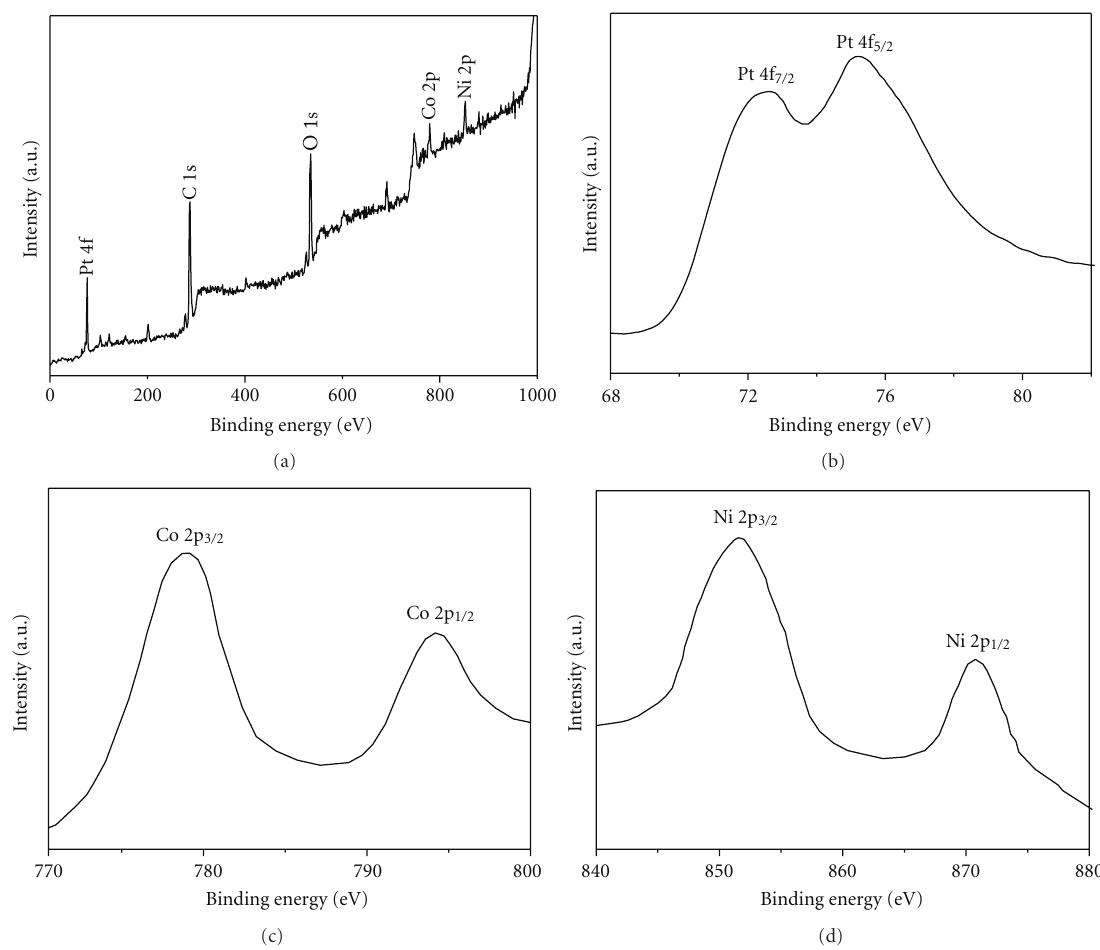
Figure 2: (a) XPS spectrum for Pt 53 -on-NiCo nanostructures; detailed spectra for (b) Pt 4f, (c) Co 2p, and (d) Ni 2p in the Pt 53 -on-NiCo nanostructures. The horizontal axe represents the binding energy corrected by that of C 1s.